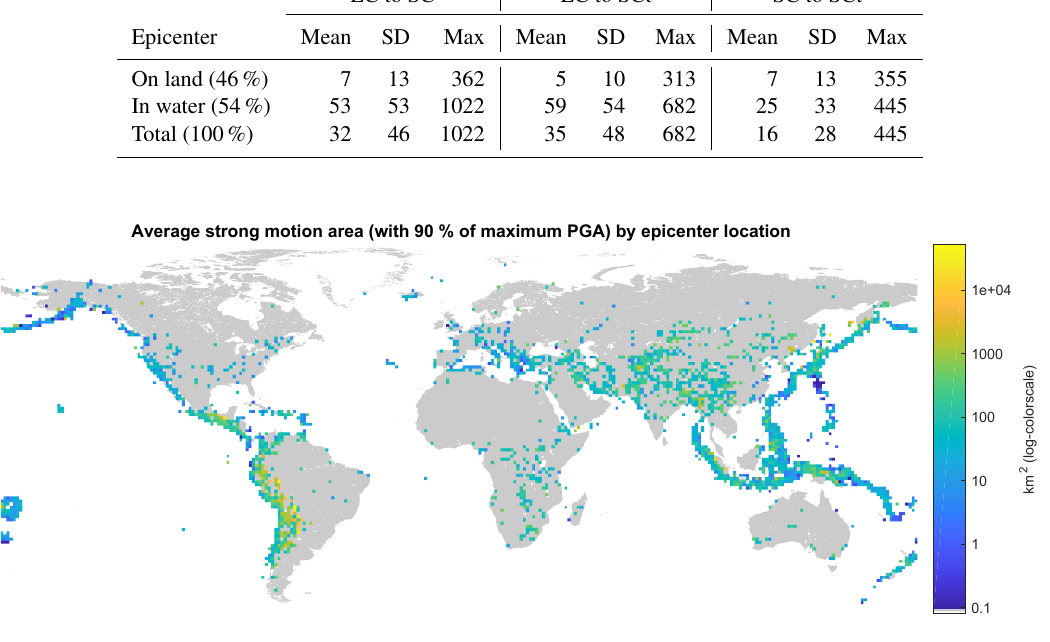
Figure 5. Attenuation across the world illustrated by average strong ground motion area for 1973–2015. This map shows the average area that was exposed to at least 90% of the maximum PGA for an earthquake with the epicenter at that location. For each 1.25 × 1.25 ◦ grid cell the average area is calculated for all earthquakes of the 12388 ShakeMaps with magnitude 4.5 or greater, which have their epicenter in that grid cell. The total number of earthquakes per grid cell varies significantly and the fact that many regions have recurrence intervals of more than 43 years for strong events makes this map particularly sensitive to the time interval of the